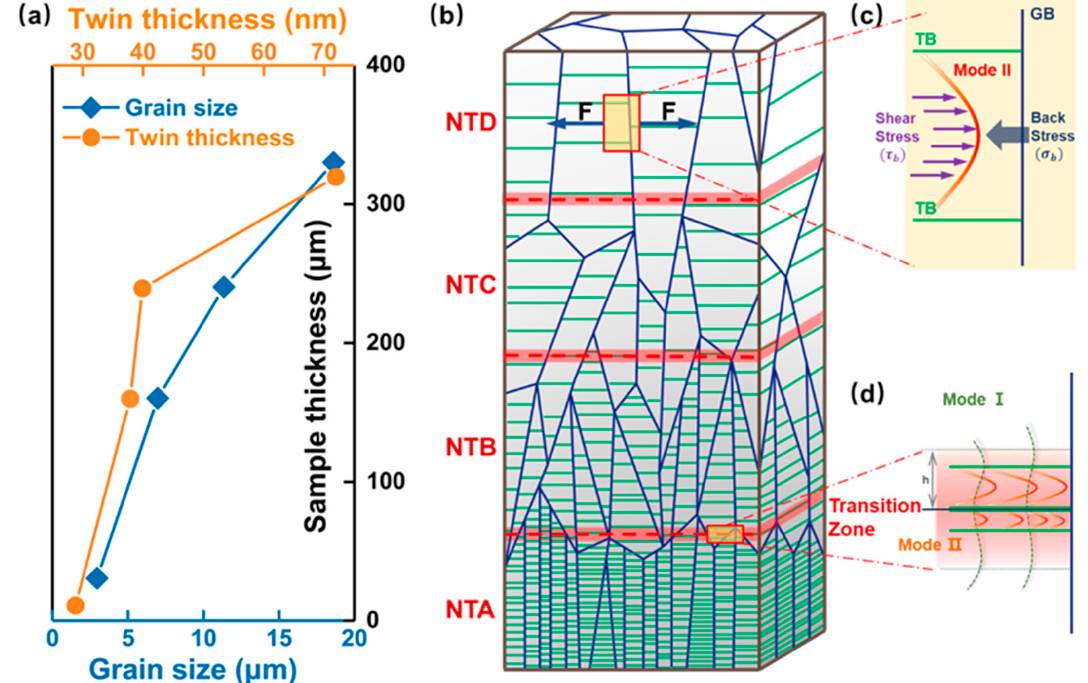
Figure 1. Schematic structure of the gradient nanotwinned (GNT) sample and microscopic deformation mechanisms. ( a ) The practical grain size and twin thickness in the experimental samples. ( b ) A GNT structure composed of four nanotwinned (NT) individual parts each with uniform twin thickness. ( c ) Mode II dislocations accumulate nearby grain boundaries (GBs) under uniaxial tensile. ( d ) Bundles of concentrated dislocations (BCDs) interact in the transition zone. Experimental data come from Ref. [5].